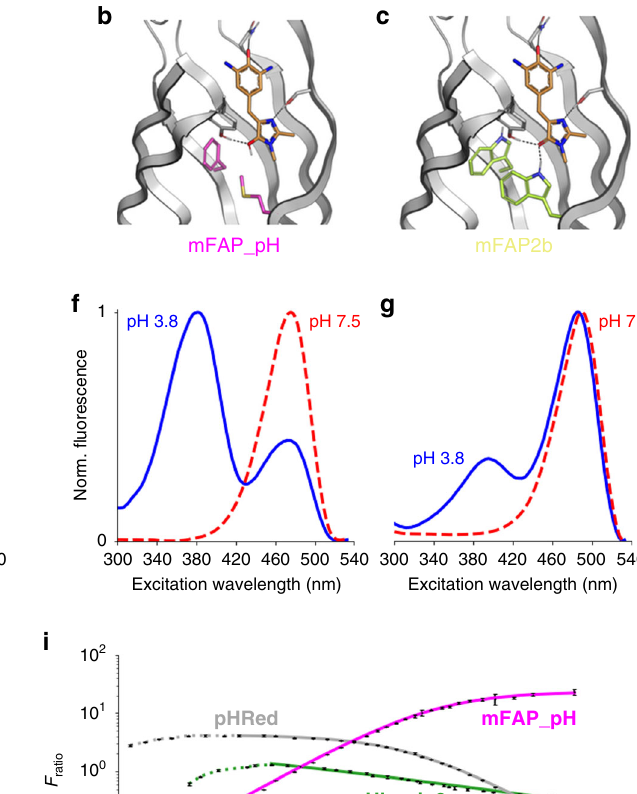
tile motion. Inhibition of Ca 2 + reuptake into the SR by treatment with cyclopiazonic acid (CPA) resulted in a sustained increase in